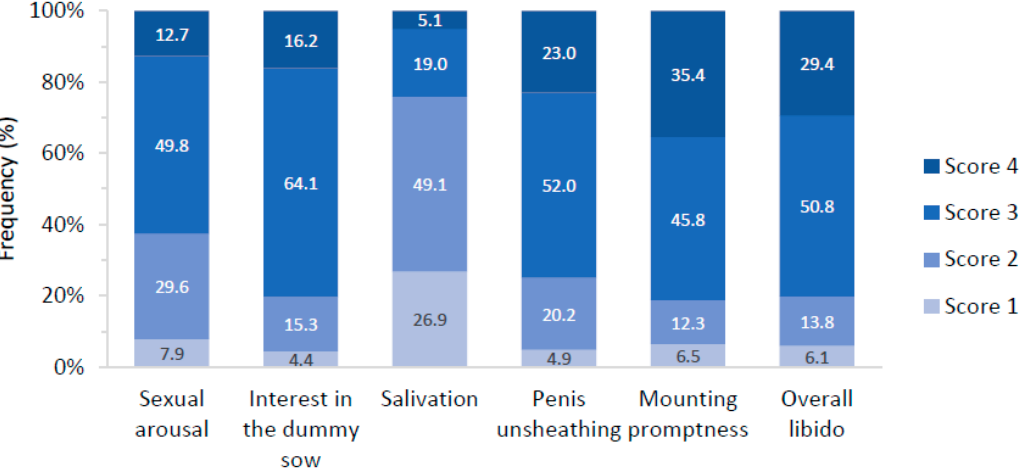
Figure 1. Distribution (%) of the scores (1 = poor; 4 = good) for the sexual behavior traits evaluated during the last session of training of the boars with the dummy sow.